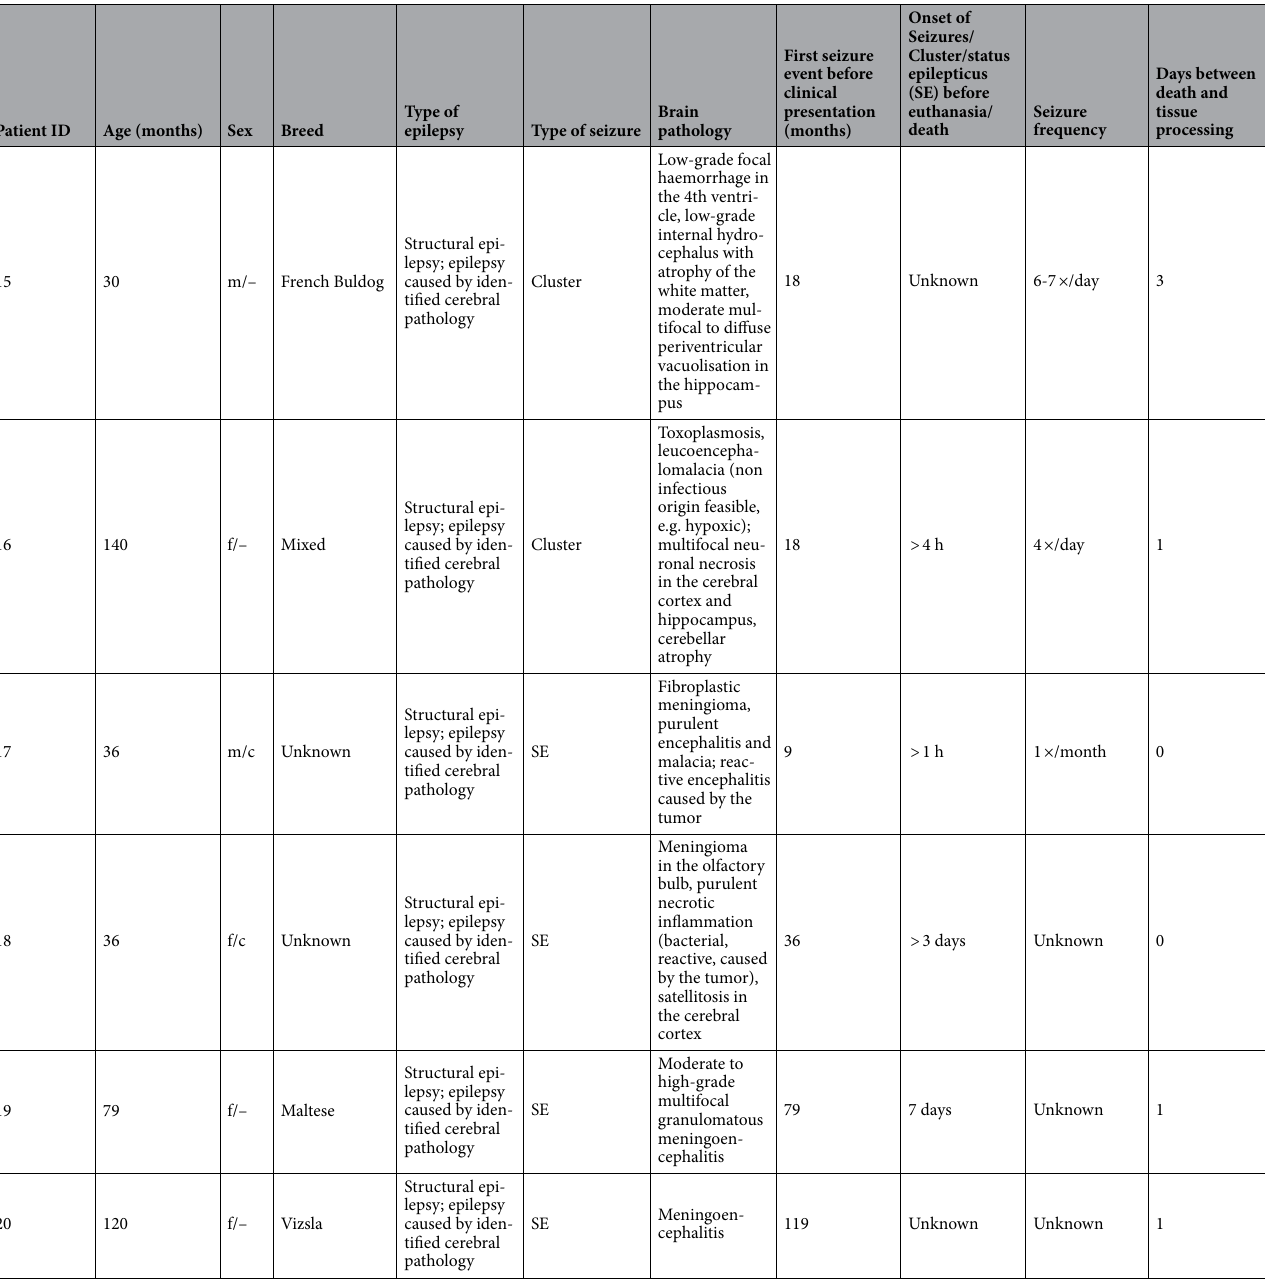
Table 1. Patient information for dogs with epilepsy included in the study. Clinically relevant information regarding canine patients with epilepsy. m/– male, not castrated; f/– female, not castrated; m/c male, castrated; f/c emale, castrated; SE status